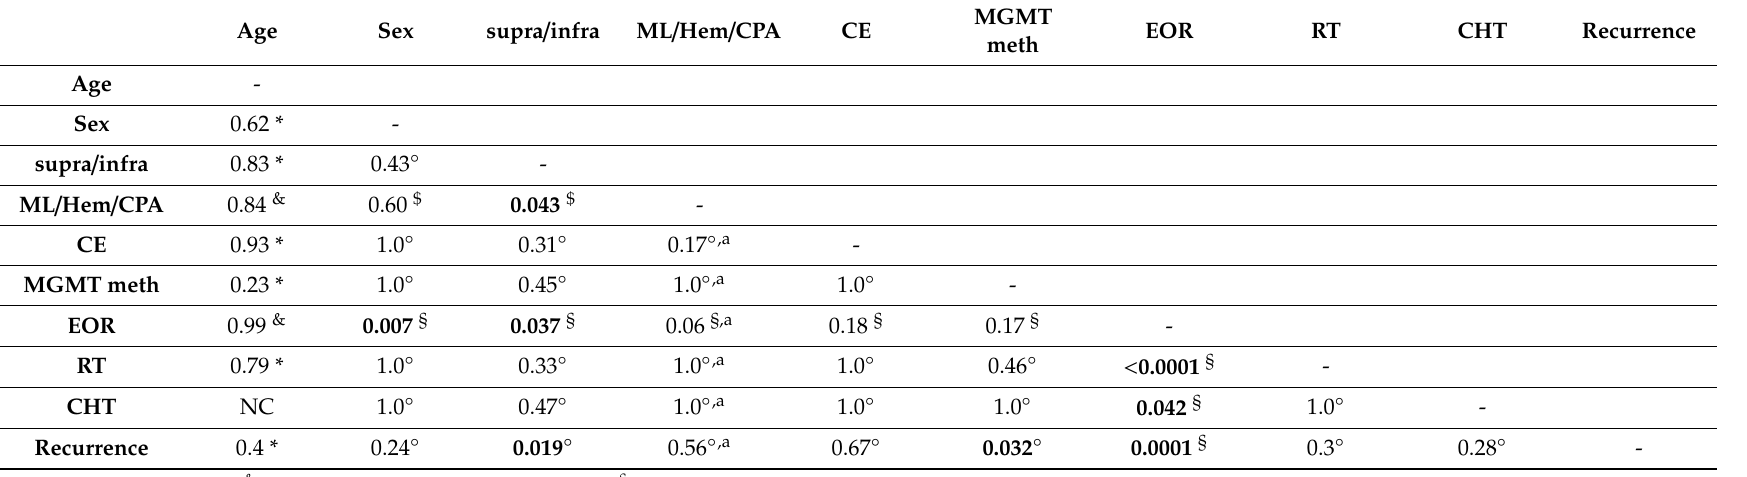
Table 2. Association studies of potential covariates in the complete cohort (n =